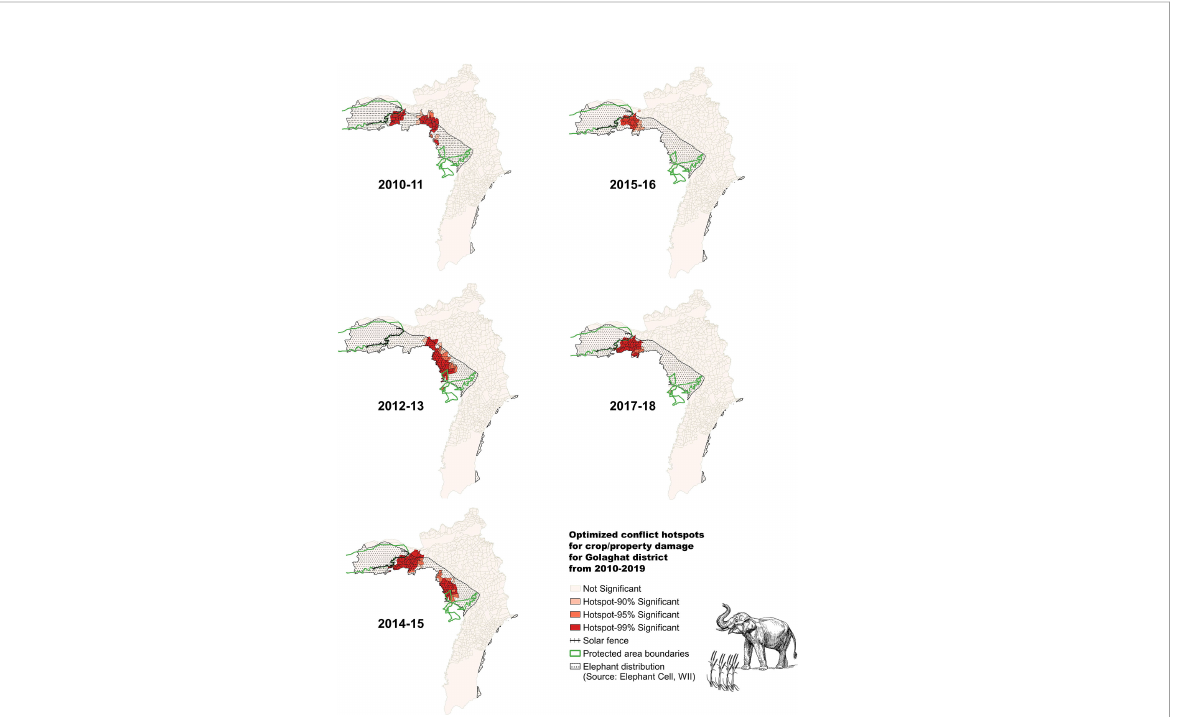
FIGURE 3 Con fl ict distribution and dispersion over the time period between 2010 and 2019 in the form of optimized crop/property damage hotspots for Golaghat